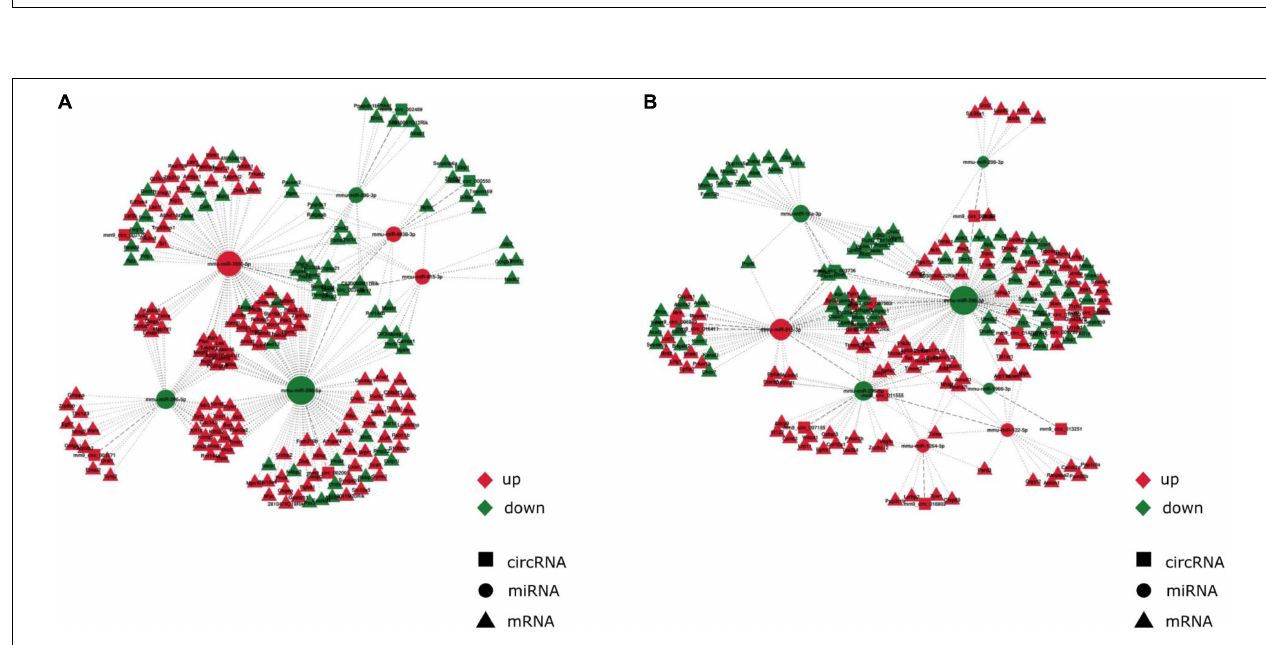
FIGURE 3 | Anesthesia/surgery caused age-dependent changes in circRNA-associated-ceRNA networks. The ceRNA networks are constructed by the interactions of circRNA-miRNA and miRNA-mRNA (A) CircRNA-associated-ceRNA network under control conditions. (B) CircRNA-associated-ceRNA network under anesthesia/surgery conditions. Red color represents upregulated expression. Green color represents downregulated expression.